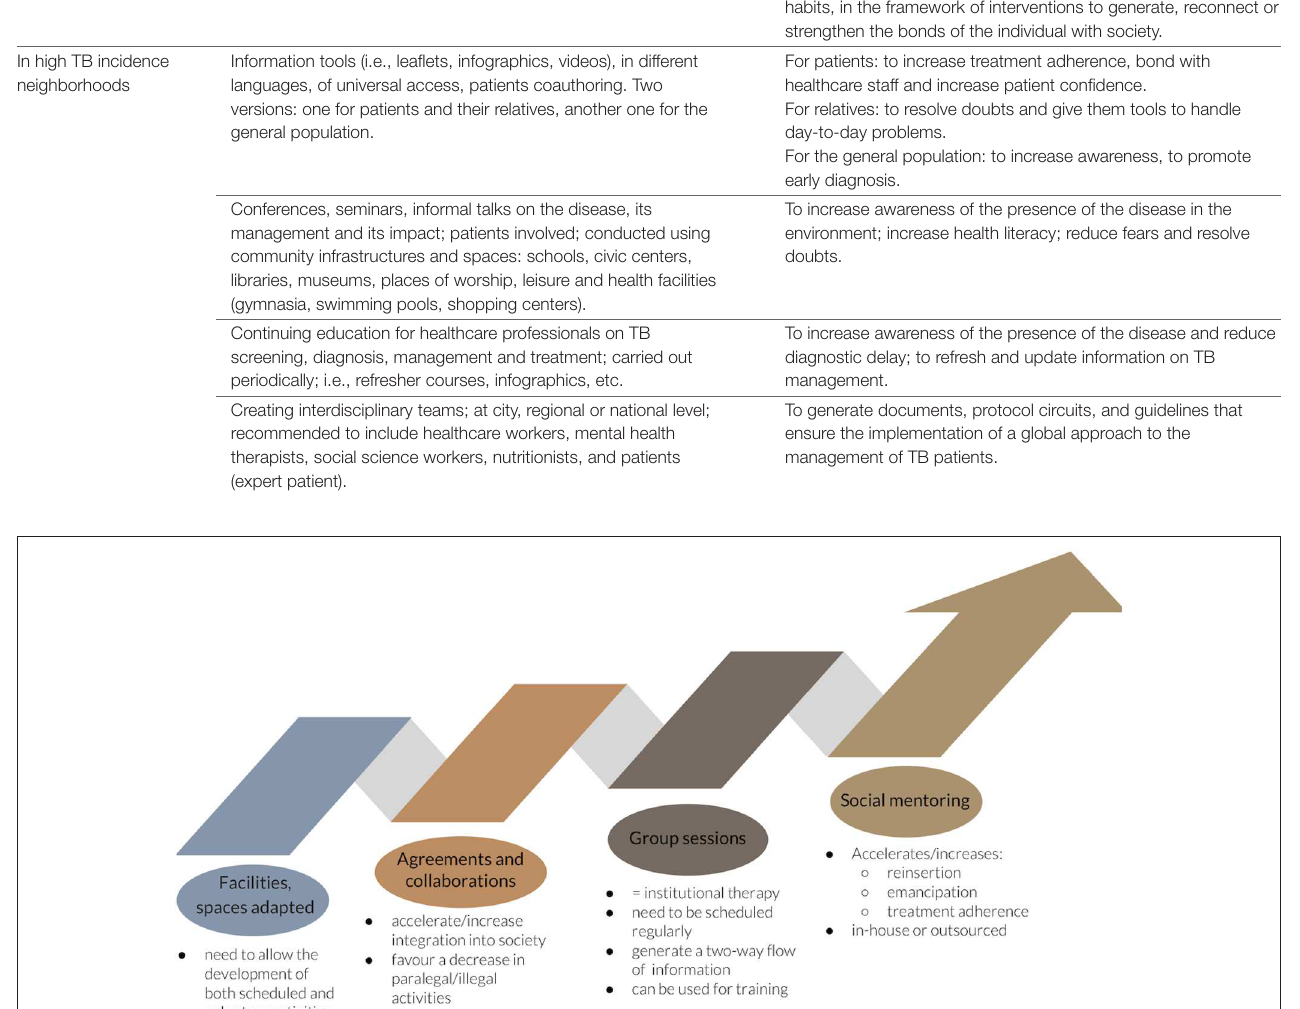
EU” (9), we have devised a series of specific proposals applicable to Barcelona that could be extrapolated to other cities with similar epidemiological